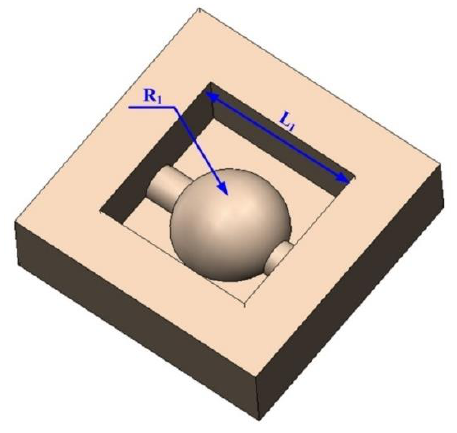
Figure 9. The computer-aided design (CAD) model of 3D microstructure.